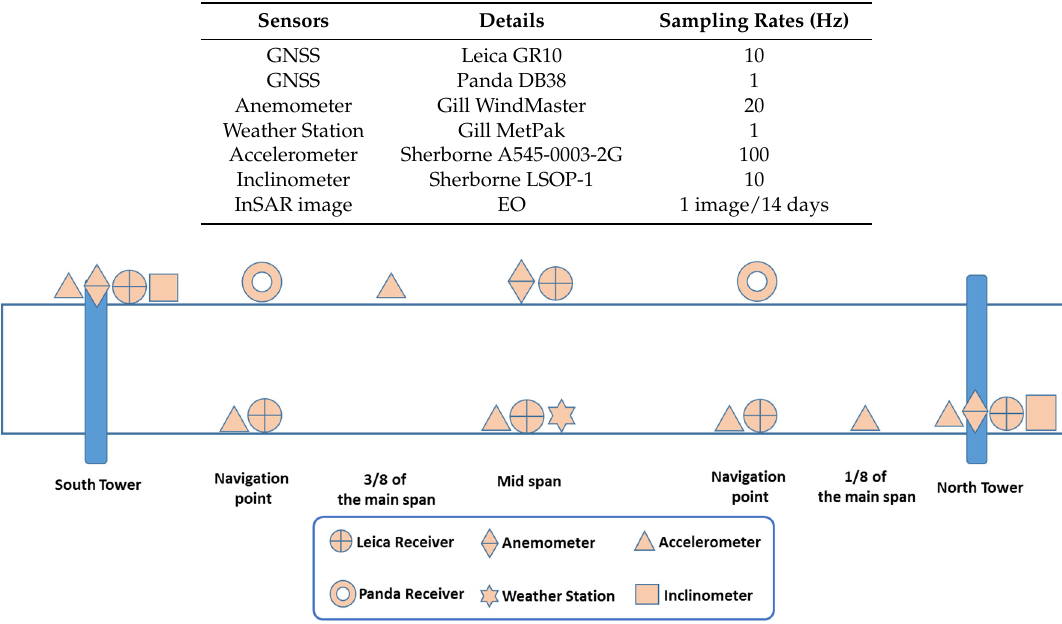
Figure 4. Locations of sensors to be installed in the GeoSHM Demo project.